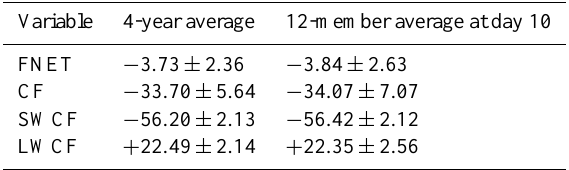
Table 3. Global mean TOA net radiative flux (FNET), total cloud forcing (CF), shortwave cloud forcing (SWCF), and long-wave cloud forcing (LWCF) in the parametric sensitivity simulations de- scribed in Sect. 4. The numbers given are the average of 256 simu- lations/ensembles ± one standard deviation (unit: W m − 2